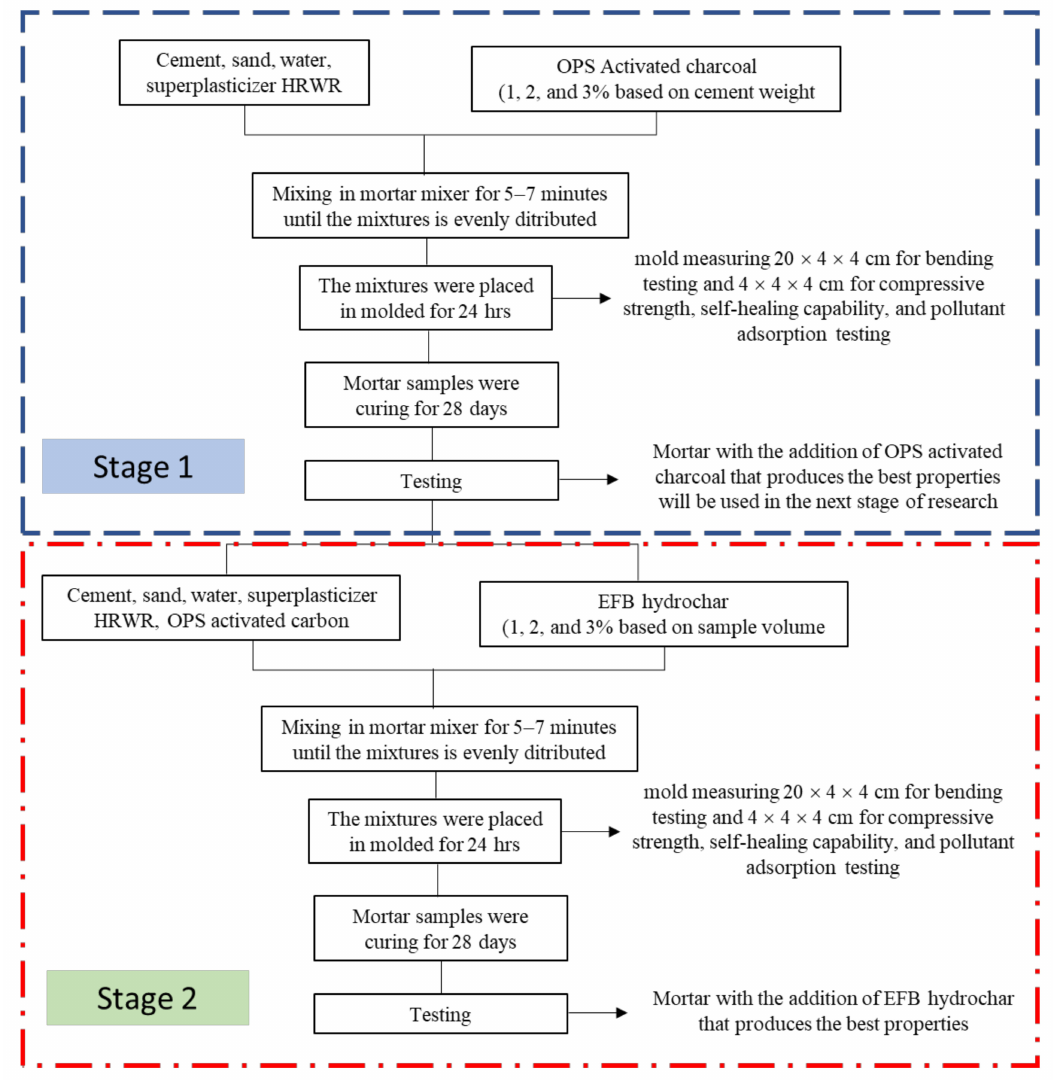
Figure 3. The flowchart of the mortar manufacturing and